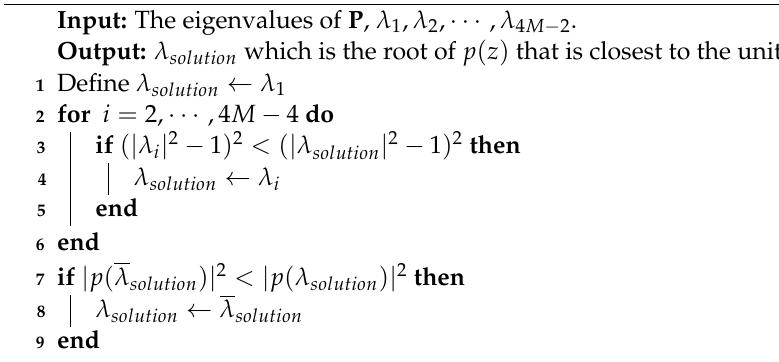
Algorithm 4: Find the eigenvalue which is the root closest to the unit